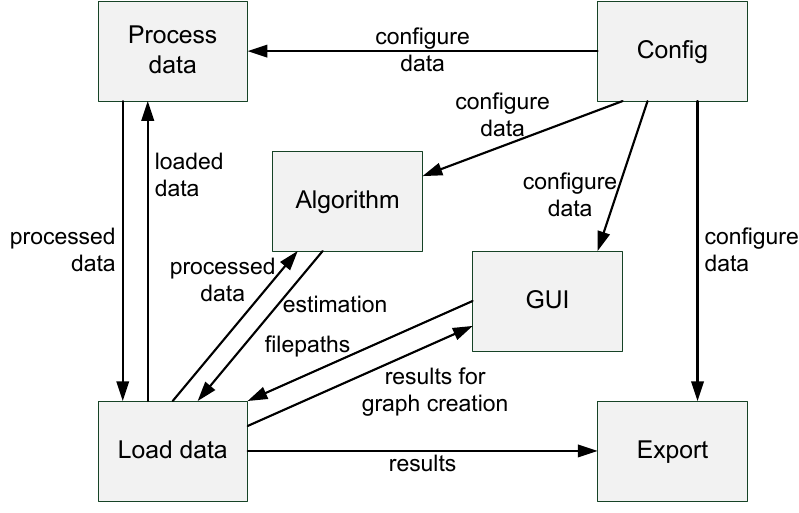
Figure 2. The architecture of the developed